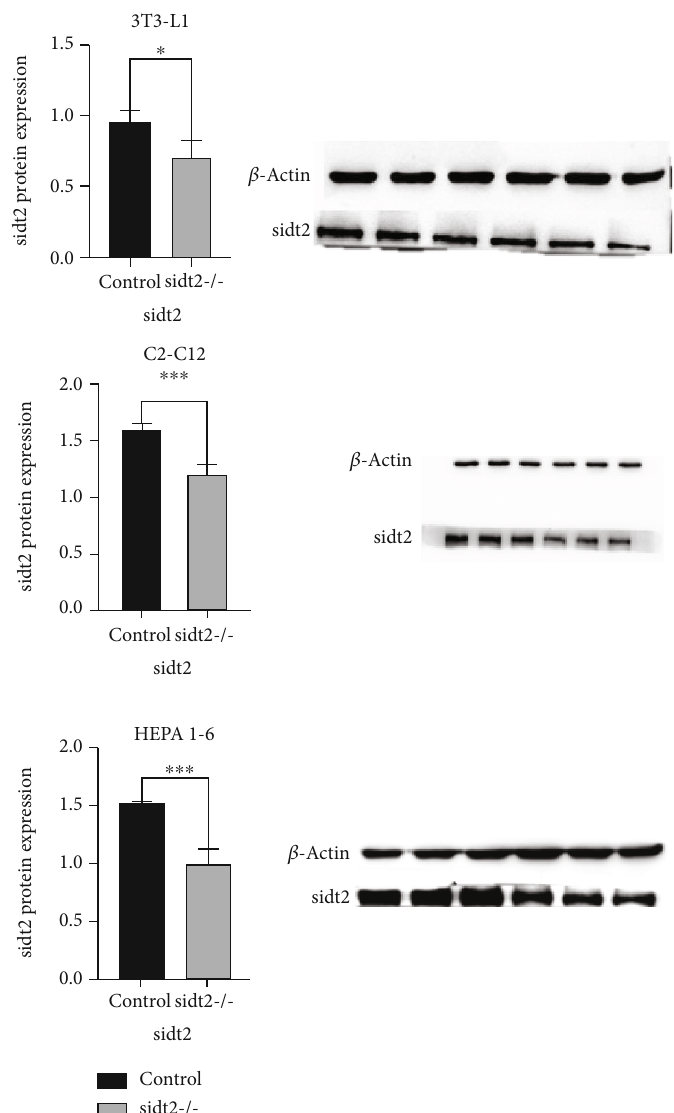
Figure 1: WB results of three cell lines, the leftmost three holes are the control group, and the right three holes are the sidt2 elimination group ( ∗ : P < 0 : 05 , ∗∗ : P < 0 : 03 , ∗∗∗ : P < 0 : 01 ). The statistical chart shows that there is a signi fi cant di ff erence in the expression of sidt2 protein between the control group and the elimination